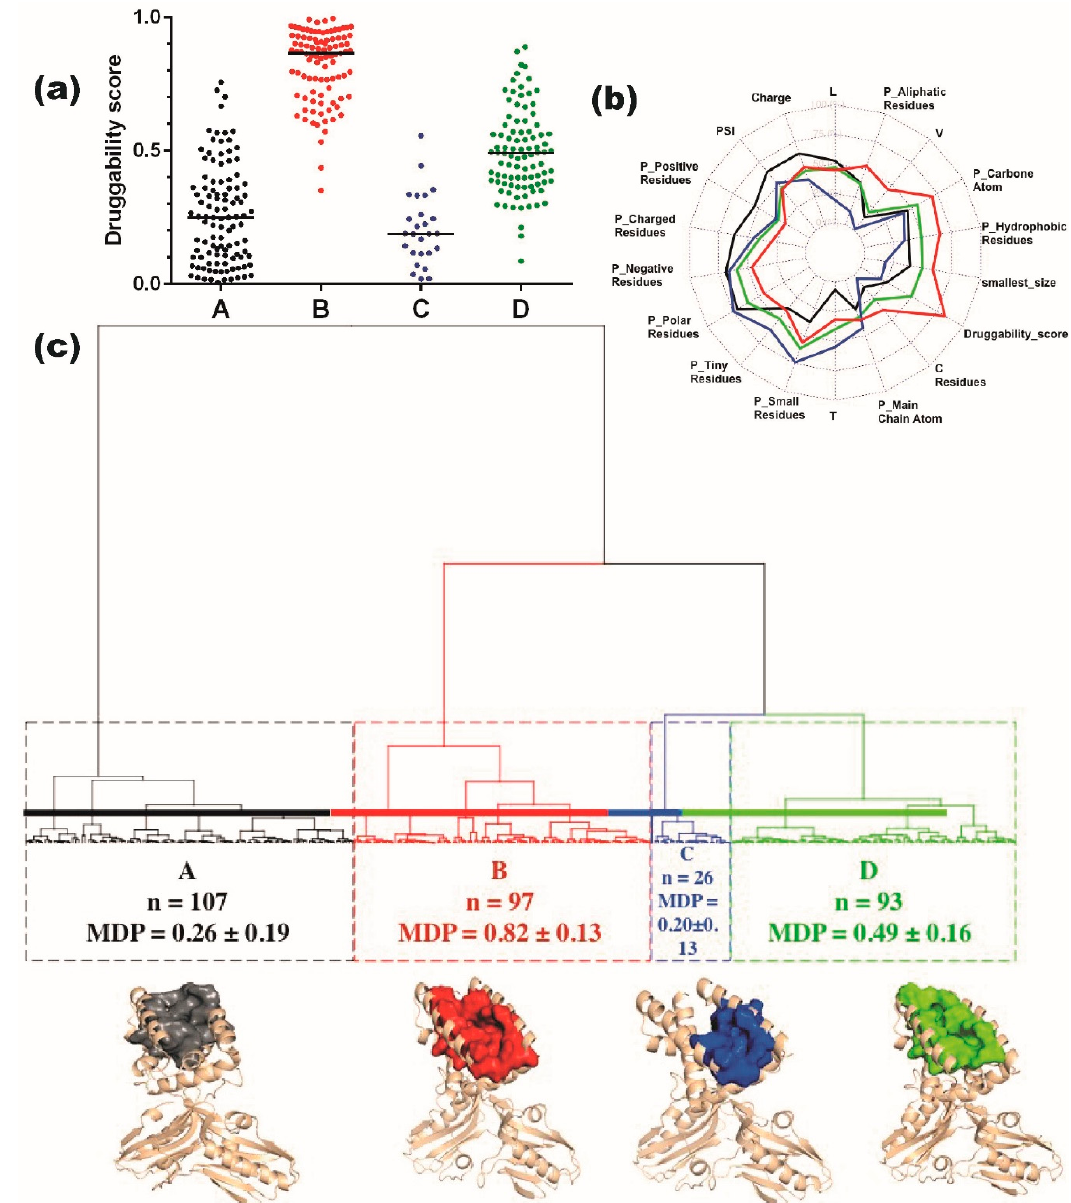
Figure 5. Groove-pocket classification: ( a ) The four groups A, B, C, and D of 323 groove-pockets, with their druggability scores. ( b ) Radar plot showing the correlation between each cluster and 18 descriptors. Colored lines correspond to the four groups of pockets (A, B, C, D, in black, red, blue and green, respectively). ( c ) Hierarchical clustering, with a surface rendering of a representative pocket from each of the four groups. The number of pockets, the mean druggability score (MDP) and its corresponding standard deviation are given for each class. The representative structures of NS1 (cartoon format) and of the groove-pockets (surface rendering) for each cluster are also shown.